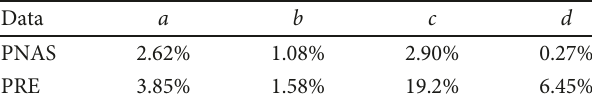
Table 1: Speci fi c statistical indexes of the empirical